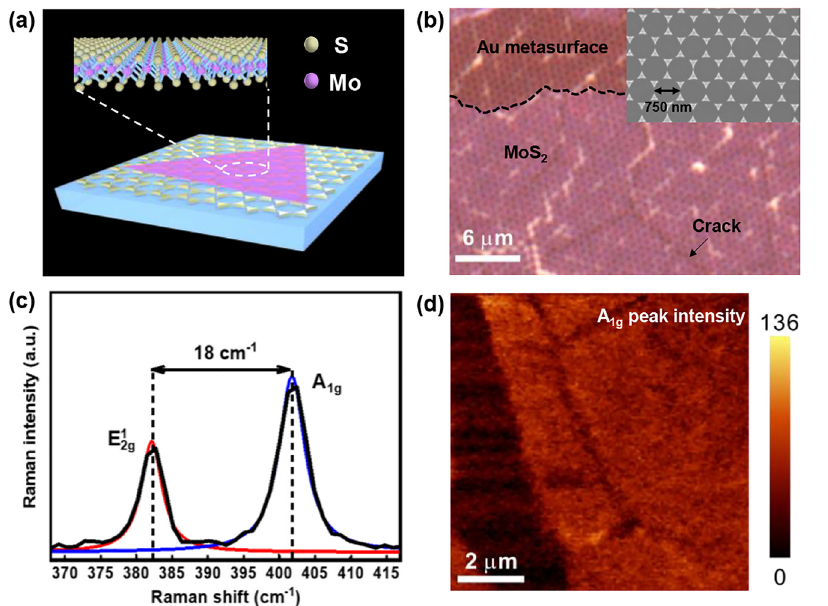
The fabricated Au metasurfaces consist of hexagonally arranged triangle prisms. Each triangle prism is expected to produce strong LSPRs upon excitation, which will then enhance the absorption and emission efficiency of the 1-L MoS . In our study, we fabricated the Au metasurfaces with 2 different periods and unit sizes, which were highly depen- dent on the templated masks by the self-assembled nano- spheresofdifferentsizes.ItisstraightforwardthattheLSPRs of Au metasurfaces are highly dependent on structural pa- rameters. Figure 2 shows the measured and simulated spectra of the Au metasurfaces that were fabricated from the templated masks with different nanosphere sizes (350, 400,